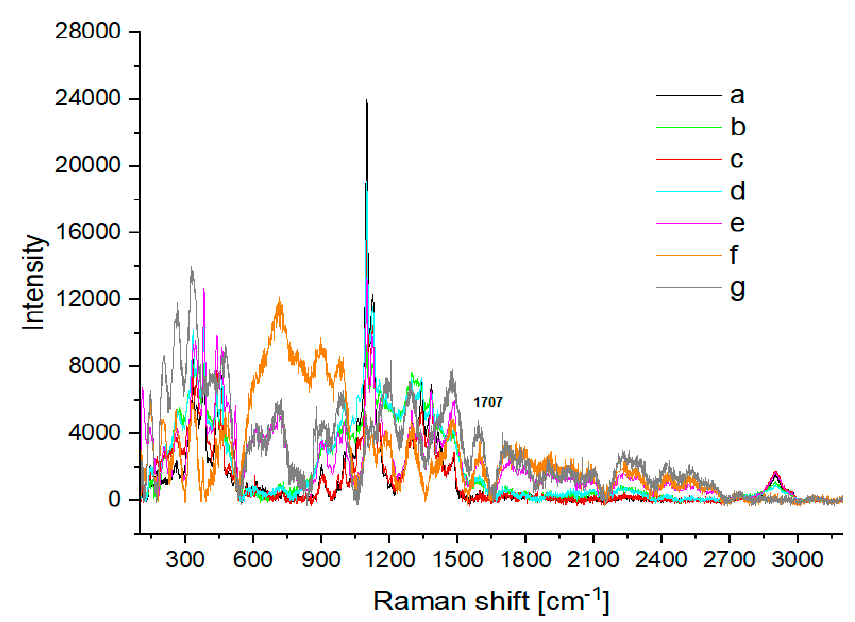
Figure 13. Raman spectra of ( a ) washed cotton and cotton treated at 120 °C with 2% H 2 SO 4 for various reaction times: ( b ) 1 h; ( c ) 2 h; ( d ) 3 h; ( e ) 4 h; ( f ) 6 h; ( g ) 8 h.